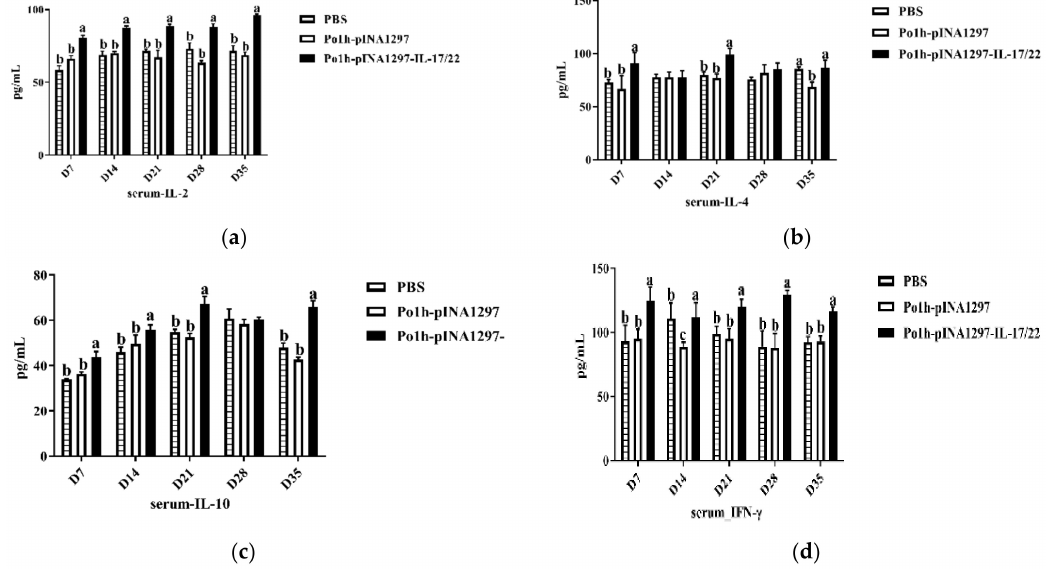
Figure 5. Concentrations of IL-2 ( a ), IL-4 ( b ), IL-10 ( c ), and IFN- γ ( d ) in the serum of the mice post inoculation. The data with different lowercase letter are significantly different, p <